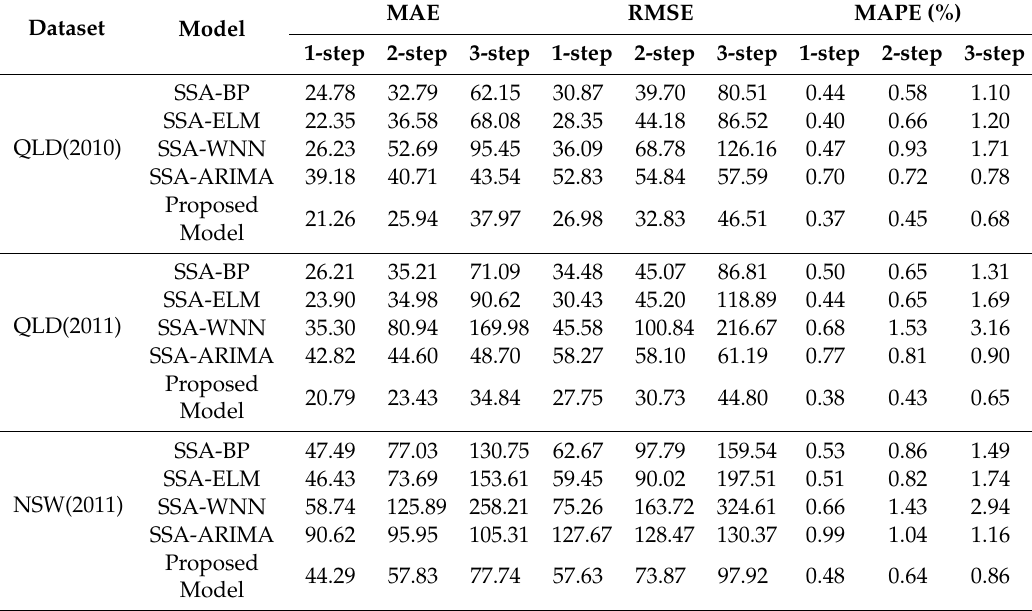
Table 3. Comparison of proposed model with other SSA-based